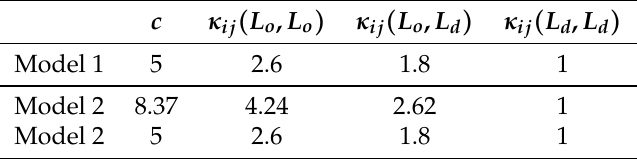
Table 3. The input parameter c automatically defines the values of κ ij and γ ij , where γ ij = 1 for Model 1 and γ ij = κ ij for Model